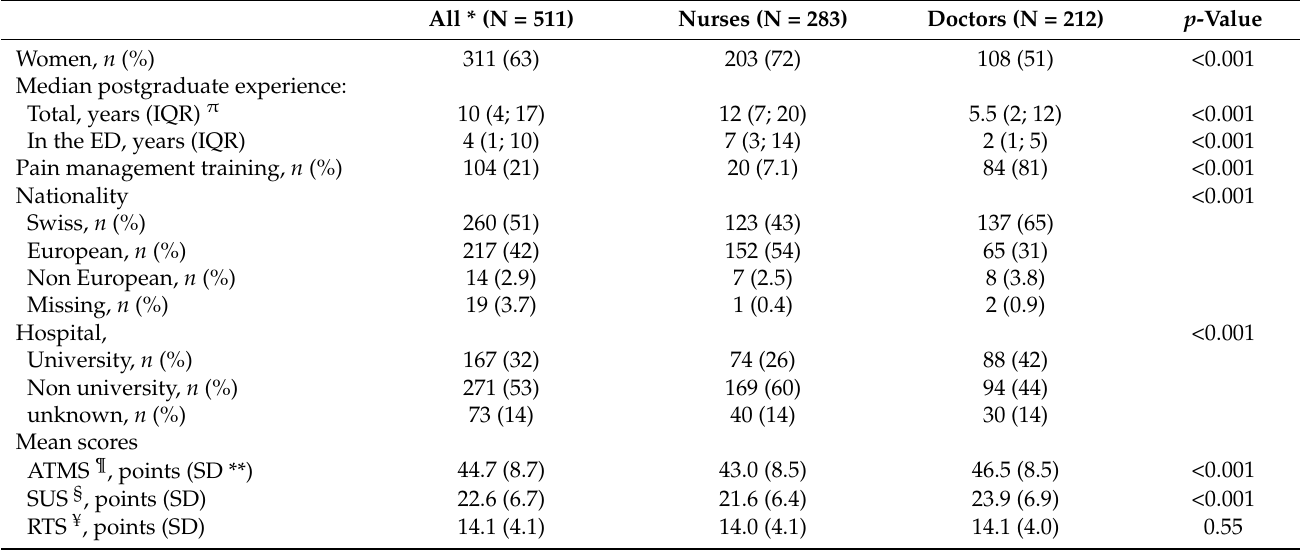
Table 1. Sociodemographic characteristics by professional category.